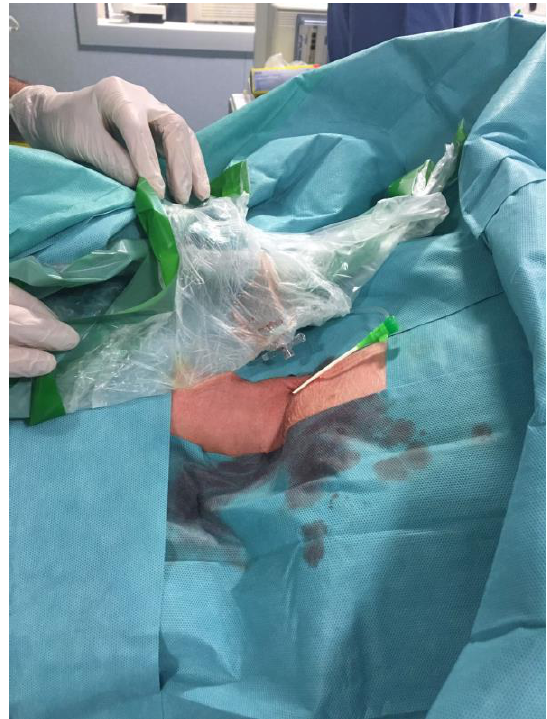
Figure 3. 6-French vascular sheath placed in the right common carotid artery after direct vessel puncture with ultrasound guide.